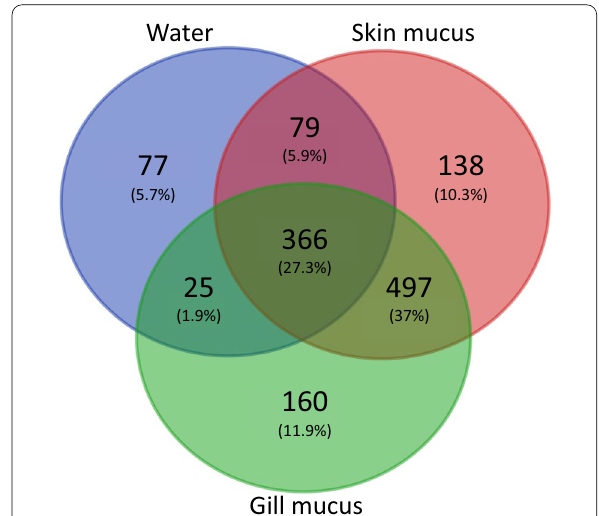
Fig. 3 Venn diagram representing shared ASVs between skin mucus (red), gill mucus (green) and water (blue). Based on 0.005% abundance cutoff